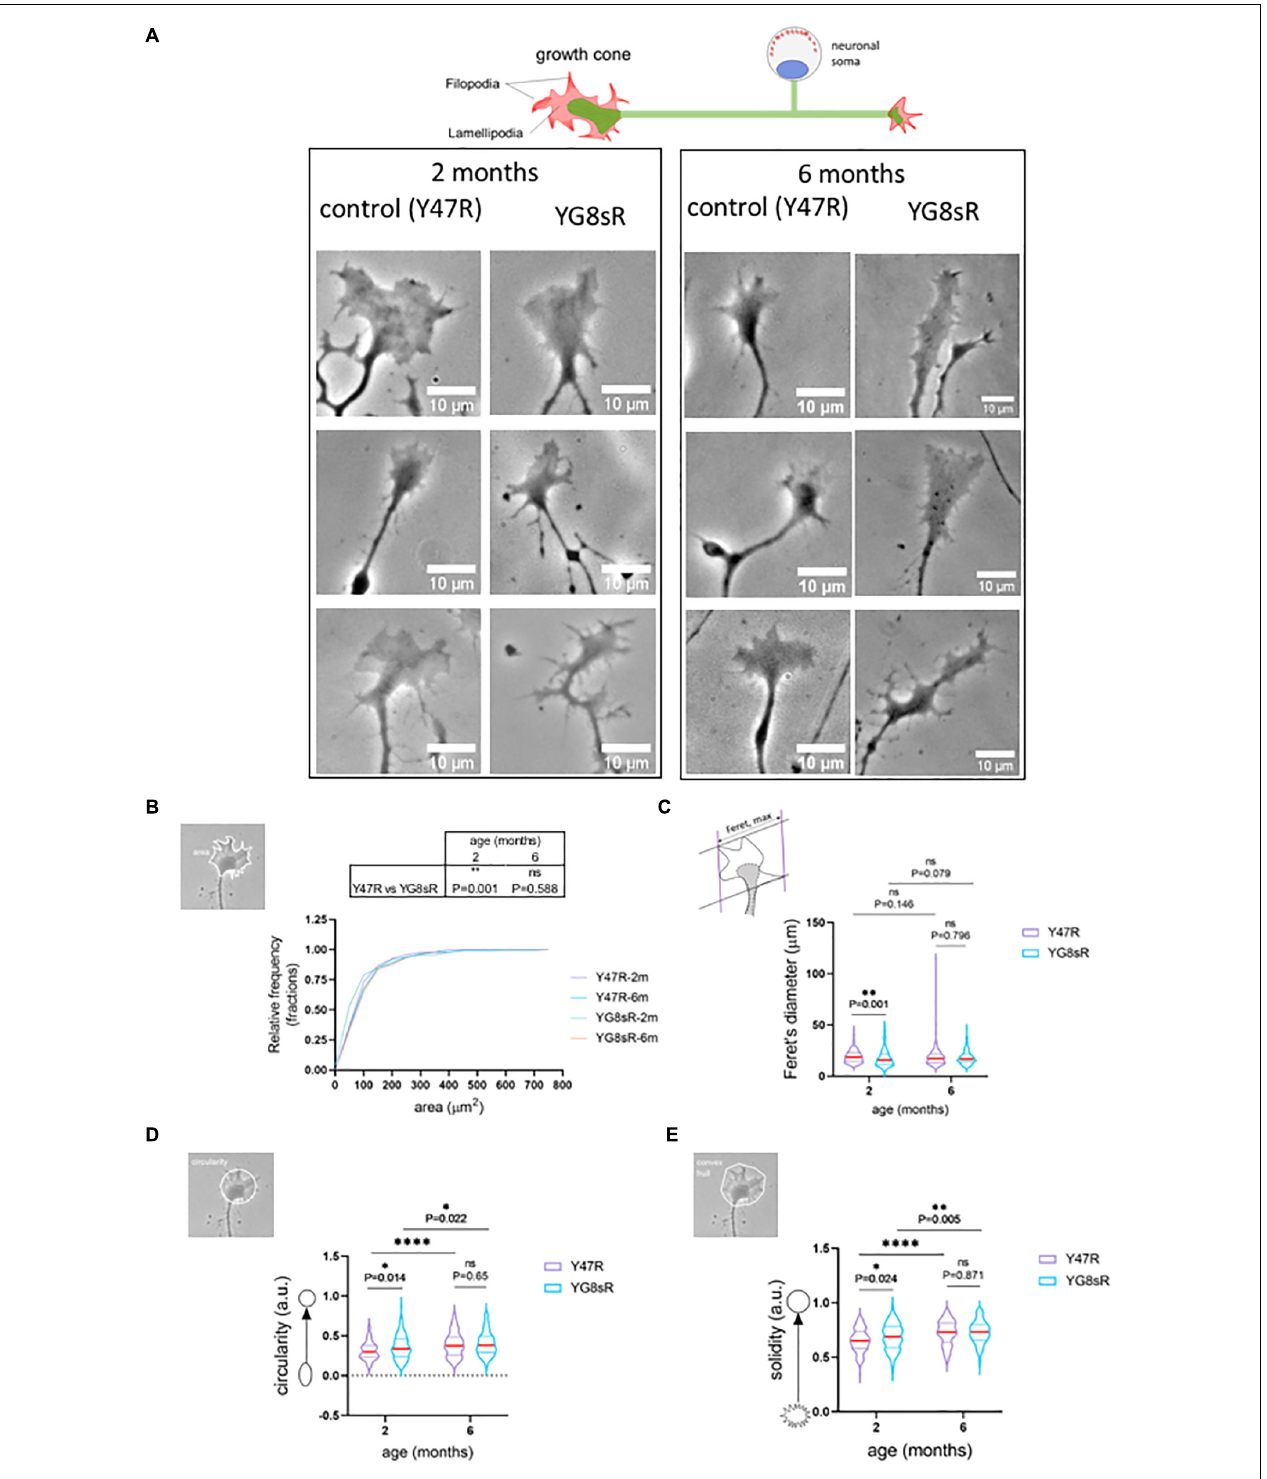
FIGURE 1 | Growth cones of frataxin deficient neurons of the YG8sR mouse are smaller and abnormal. (A) Representative phase-contrast images of three SPREAD like GCs observed in the primary culture of DRG neurons from the control (Y47R) and the YG8sR model at 2 and 6 months of age. We observed disorganization in the distribution of filopodia and lamellipodia of YG8sR-GCs. Notice the hand-like shape in the controls and the absence of this shape in the YG8sR-GCs. Also, we observed small structures, probably rich in actin, growing from the axon or neurite close to the YG8sR-GCs (black arrows). These structures are not observed in